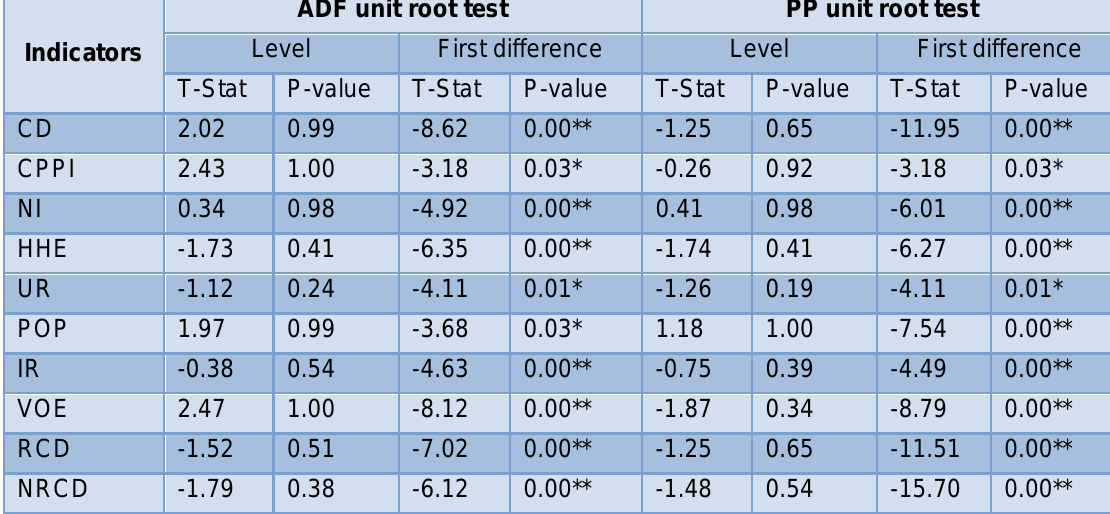
Table 1 Summarised results of ADF and PP unit root tests * denotes rejection of null hypothesis of unit root based on their P-value at the 0.05 significance level. ** denotes rejection of null hypothesis of unit root based on their P-value at the 0.01 significance